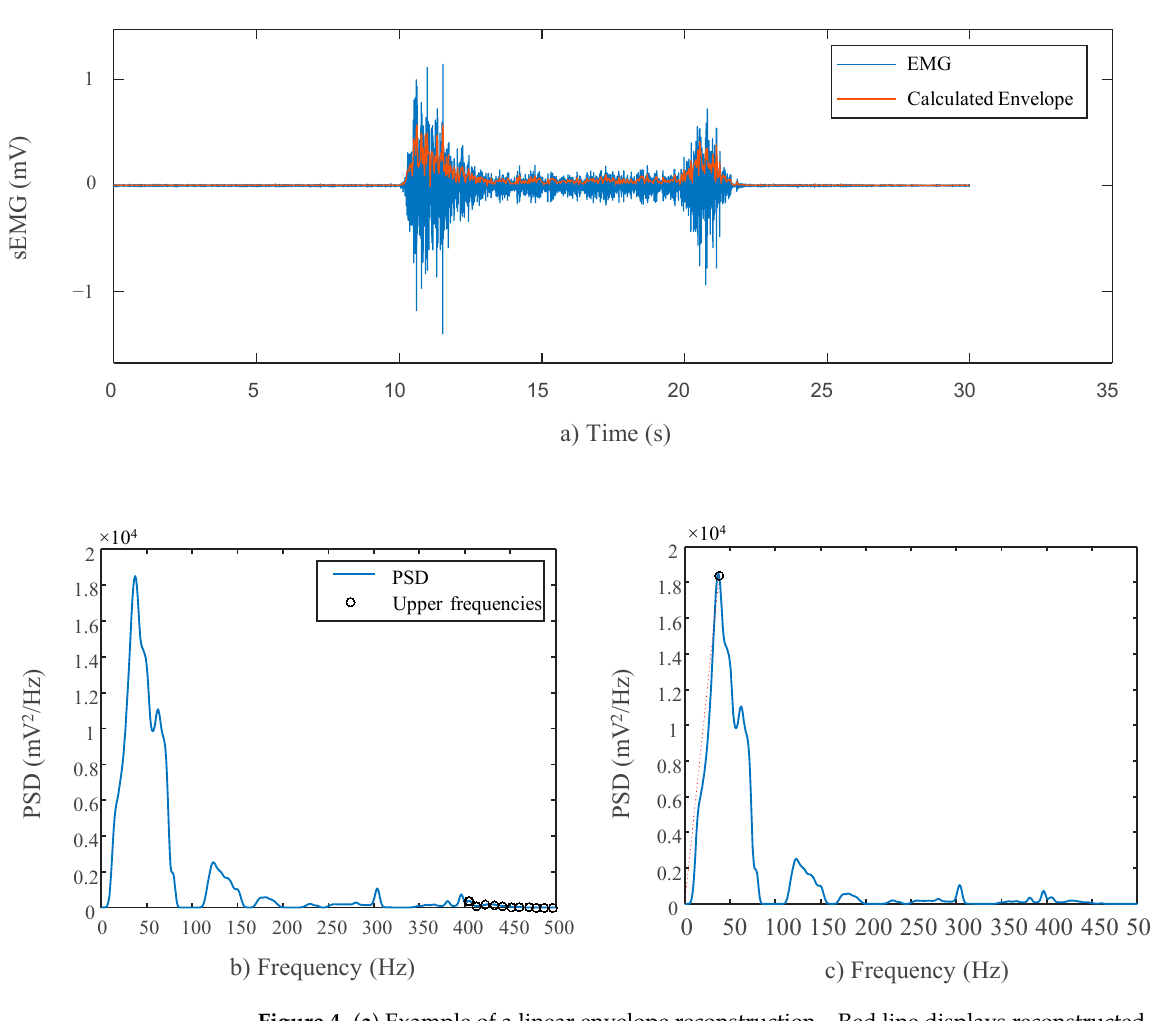
Figure 4. ( a ) Example of a linear envelope reconstruction—Red line displays reconstructed envelope for single unscaled EMG contraction; ( b ) SN Ratio illustration—Black circles denote high noise frequencies utilized in SN Ratio calculations; ( c ) SM Ratio illustration—Red dotted line denotes low frequency division, power above line marked as motion-related noise used in SM Ratio calculations.